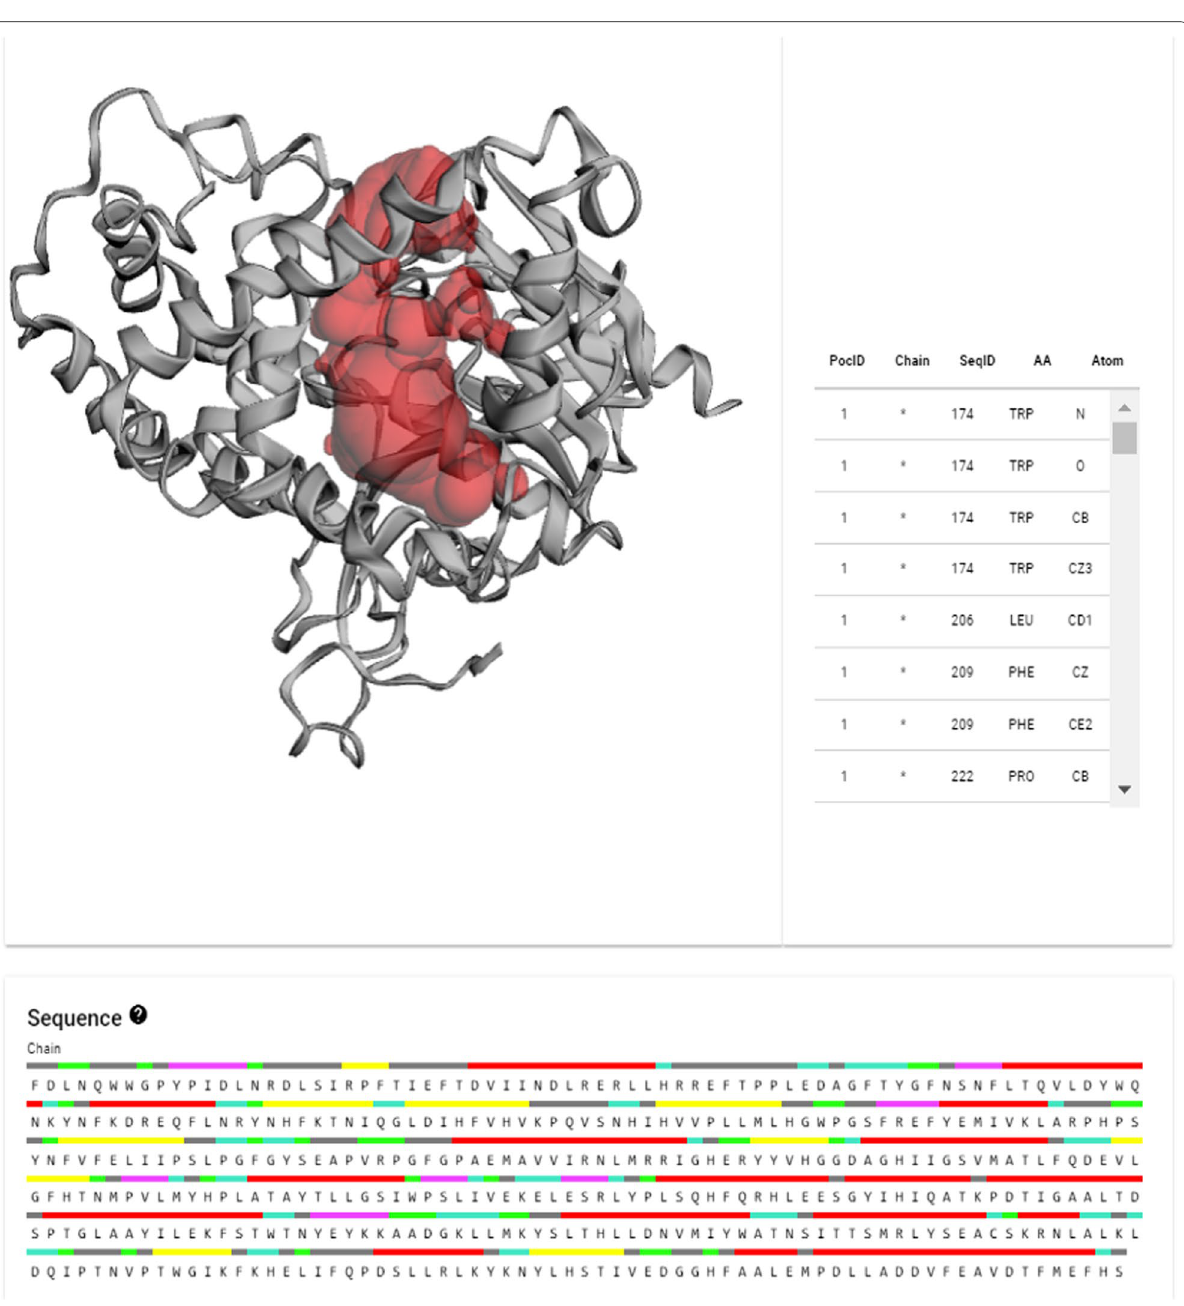
Fig. 11 Active sites of G. mellonella